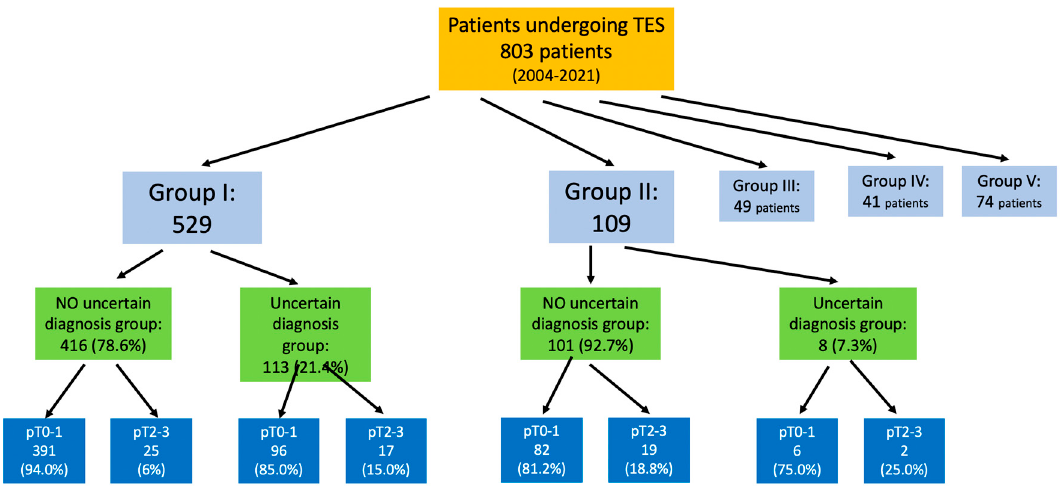
Figure 1. Flowchart of the study patients and those with uncertain diagnosis in groups I and II.